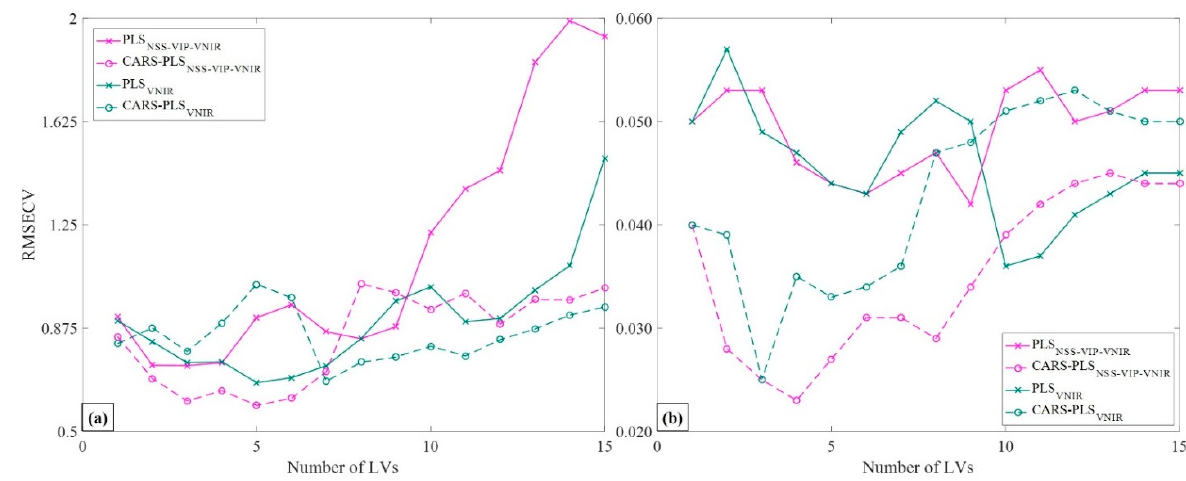
Figure 6. RMSECV for the Cd concentration against the number of LVs of PLS and CARS-PLS for different sample sets: ( a ) Hengyang and ( b ) Baoding (validation ratio = 1/5). Table 3. Prediction precision of PLS NSS-VIP-VNIR , CARS-PLS NSS-VIP-VNIR , PLS VNIR , and CARS-PLS VNIR models. Sample